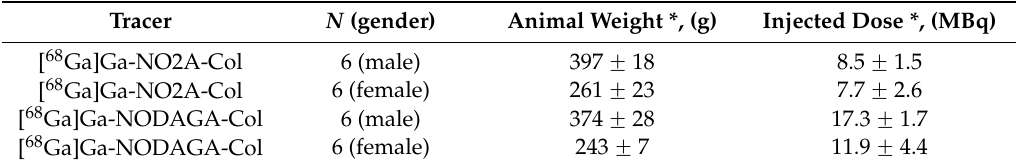
Table 1. The weight of the rats and injected radioactivity doses of [ 68 Ga]Ga-NO2A-Col and [ 68